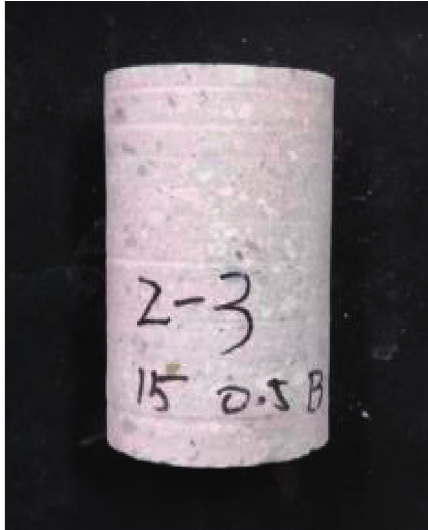
Figure 9: Specimen for the triaxial test. ( Note . The diameter of the specimen is 50 mm, and the height of the specimen is 100mm).